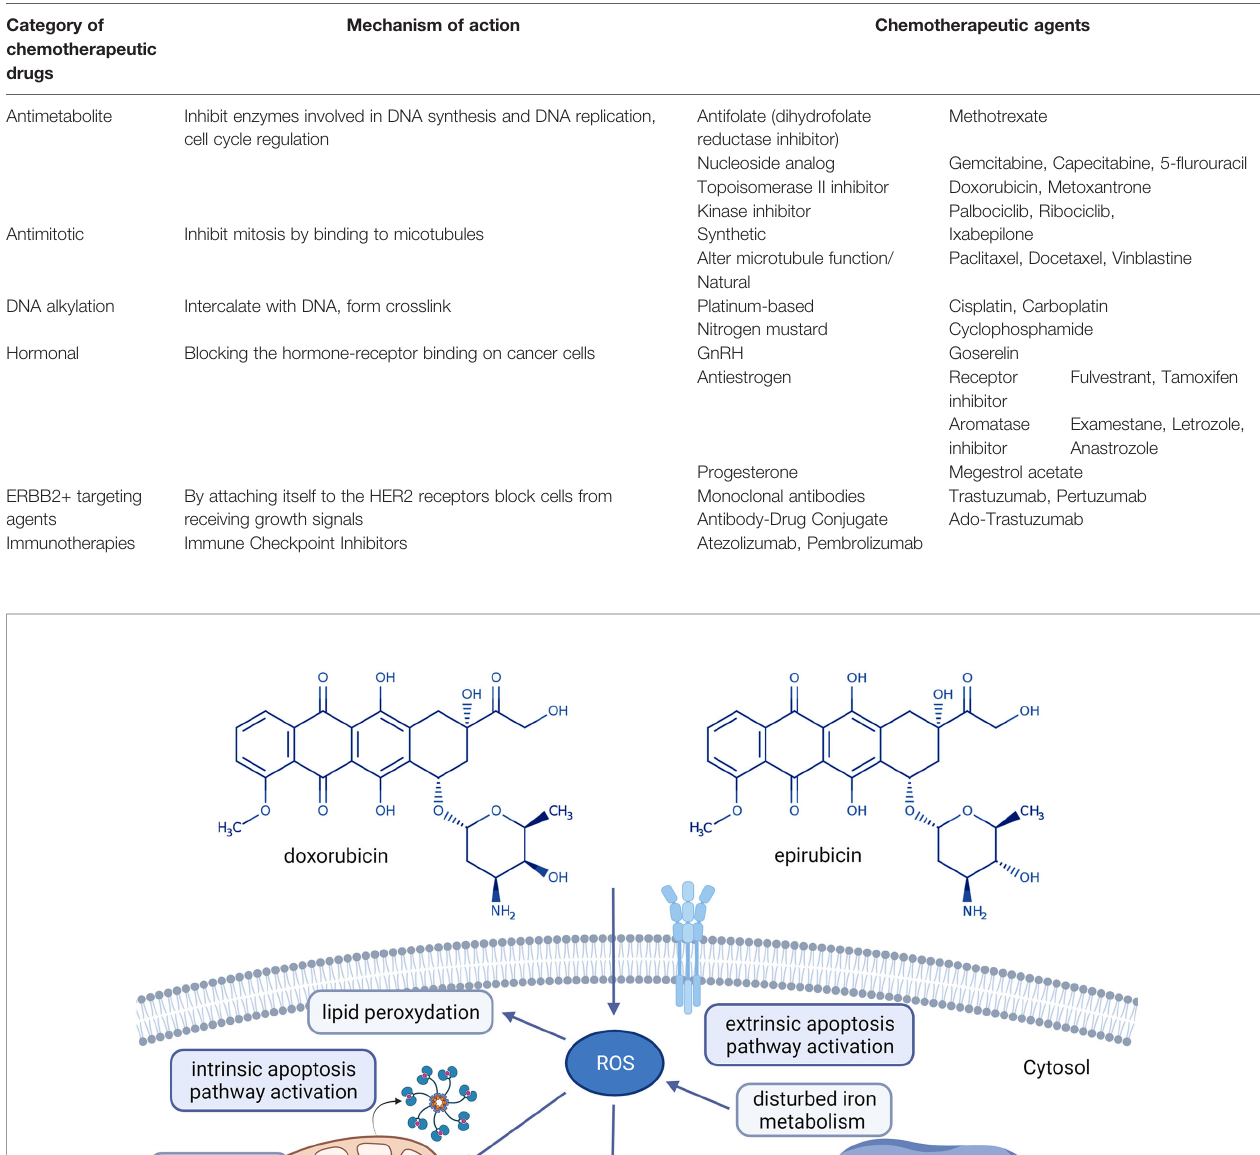
TABLE 1 | Classi fi cation of most frequently used drugs in patients diagnosed with breast carcinomas based on the mode of